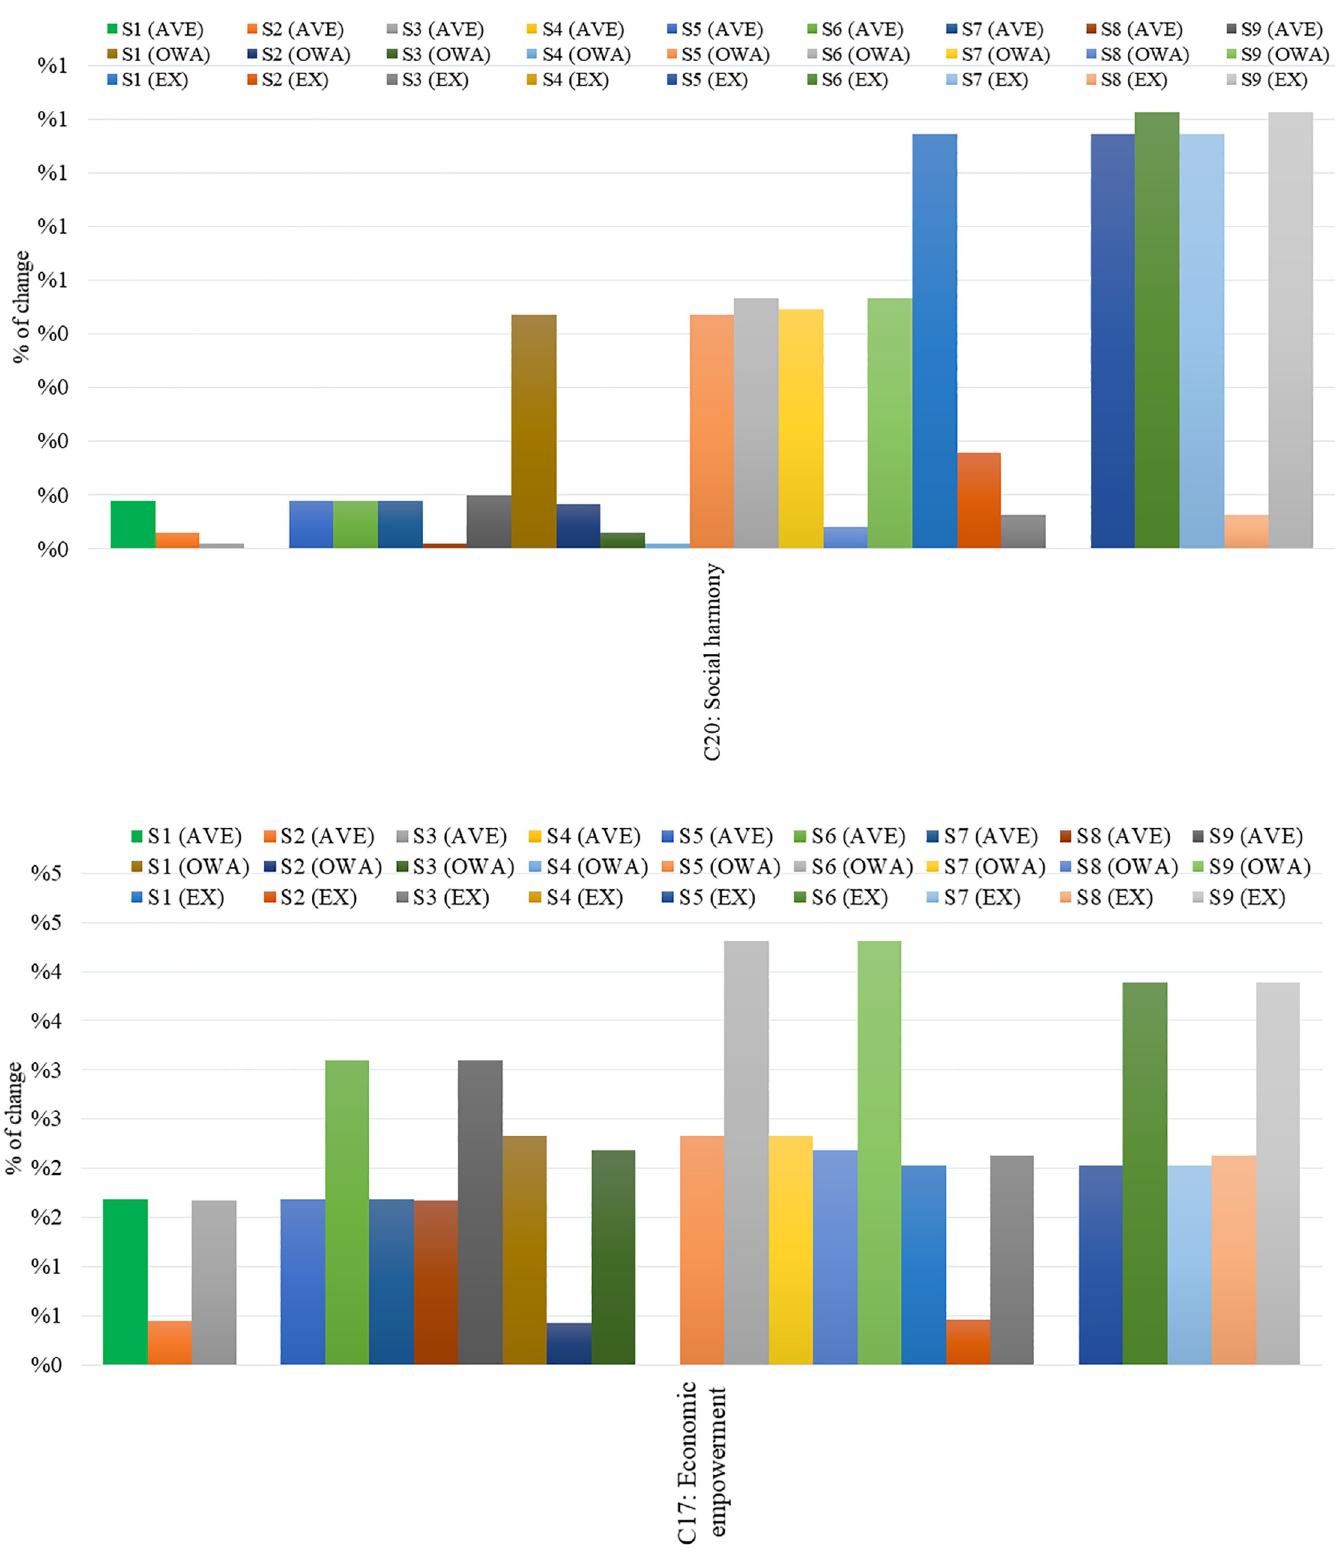
Fig 10. Deviations for concepts (a) C20 and (b) C17 for aggregated FCMs considering confidences and links.